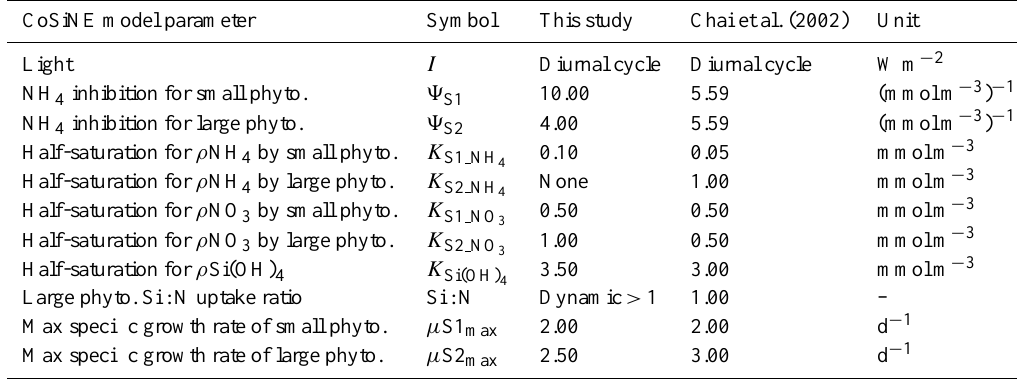
Table 1. Optimized CoSiNE model parameters. Key model parameters used in this study are compared with the early CoSiNE model parameterization applied by Chai et al. (2002). CoSiNE model parameter Symbol This study Chai et al. (2002) Unit Light I Diurnal cycle Diurnal cycle Wm − 2 NH 4 inhibition for small phyto. 9 S1 10.00 5.59 (mmolm − 3 ) − 1 NH 4 inhibition for large phyto. 9 S2 4.00 5.59 (mmolm − 3 ) − 1 0.10 0.05 mmolm − 3 Half-saturation for ρ NH 4 by small phyto. K S1 NH 4 Half-saturation for ρ NH 4 by large phyto. K S2 NH None 1.00 mmolm − 3 4 0.50 0.50 mmolm − 3 Half-saturation for ρ NO 3 by small phyto. K S1 NO 3 Half-saturation for ρ NO 3 by large phyto. K S2 NO 1.00 0.50 mmolm − 3 3 Half-saturation for ρ Si(OH) 4 K Si(OH) 3.50 3.00 mmolm − 3 4 Large phyto. Si:N uptake ratio Si:N Dynamic > 1 1.00 – Max specific growth rate of small phyto. µ S1 max 2.00 2.00 d − 1 Max specific growth rate of large phyto. µ S2 max 2.50 3.00 d −